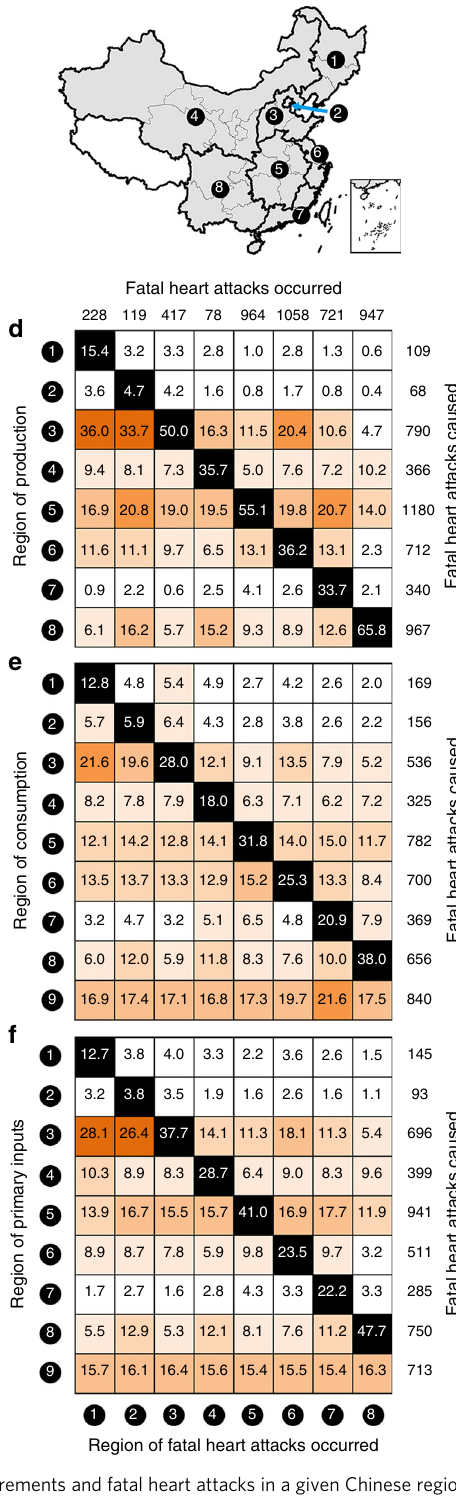
NATURE COMMUNICATIONS| (2019) 10:1484